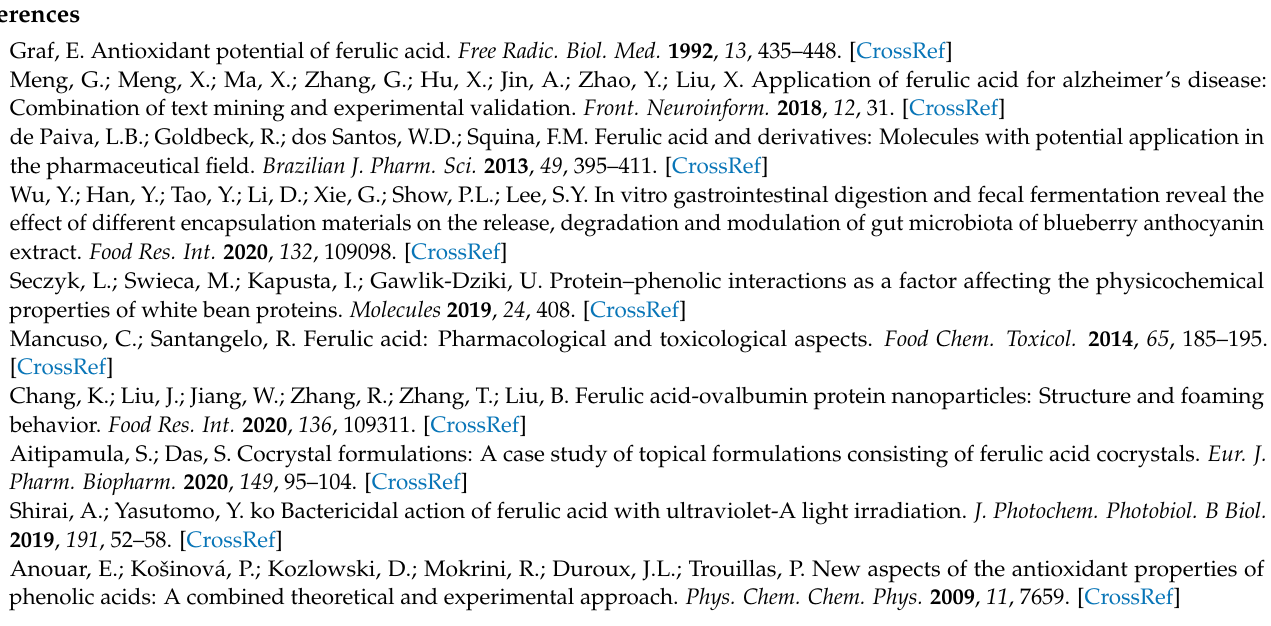
Figure S2: HPLC trace analysis of the deprotected sidechains (LW2 and CW2). Figure S3: HPLC trace analysis of the pure cyclic deprotected CEG. Figure S4: Mass spectra of peptides. Table S1: The score of molecular docking between BSA/CW2 and FA. Table S2: Yield and purity for synthesized